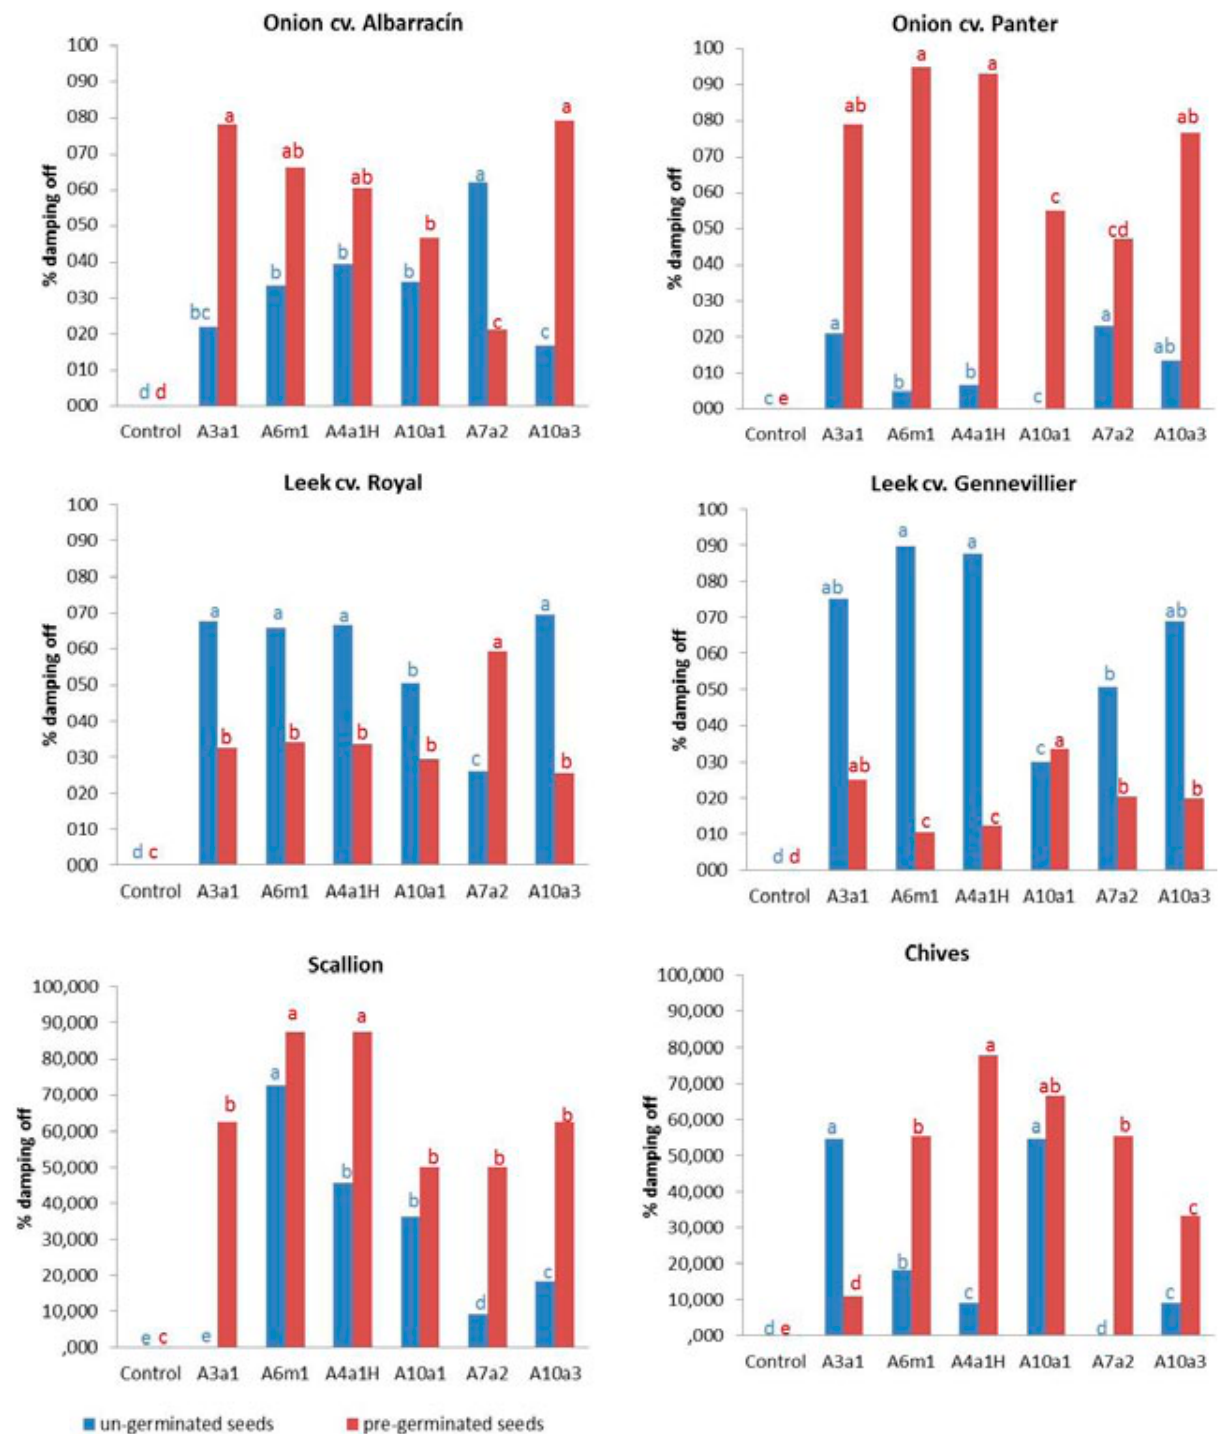
Figure 1. Effects of six isolates of Fusarium proliferatum recovered from garlic on damping off in onion, leek, chives and scal - lion seedlings. Bars topped by the same letter are not significantly different (Fisher´s protected least significant difference test; P